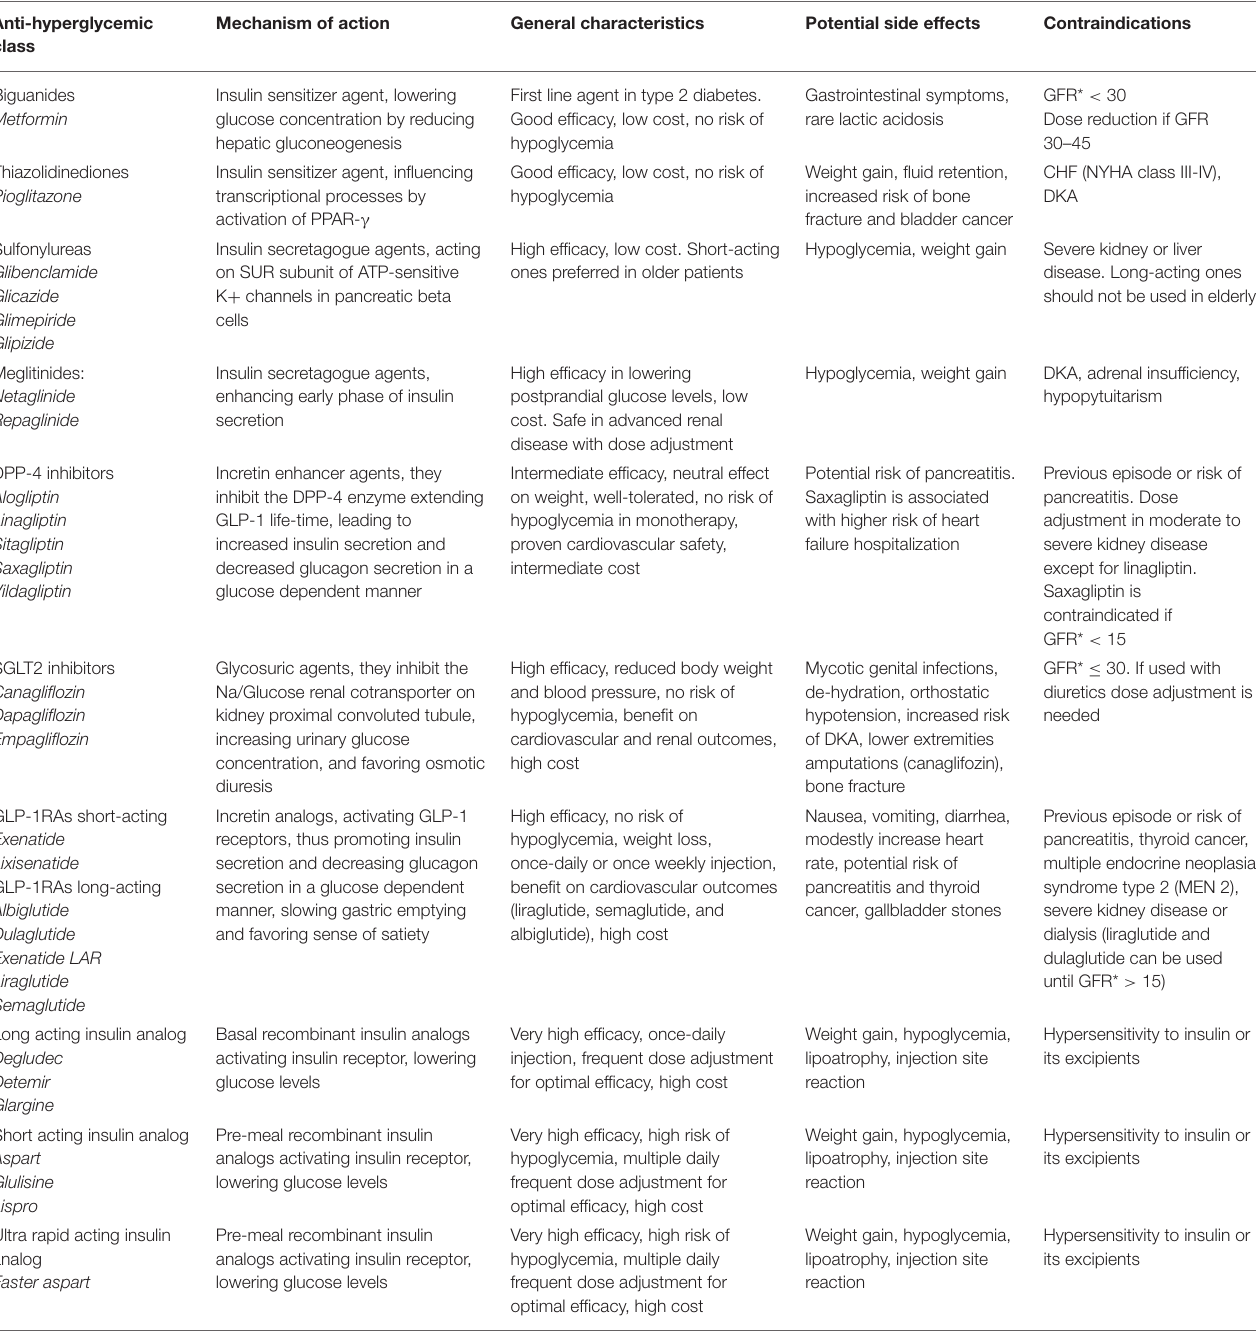
TABLE 3 | Glucose-lowering medications available in Europe with specific characteristics to drive the treatment choice for old people with type 2 diabetes. Anti-hyperglycemic